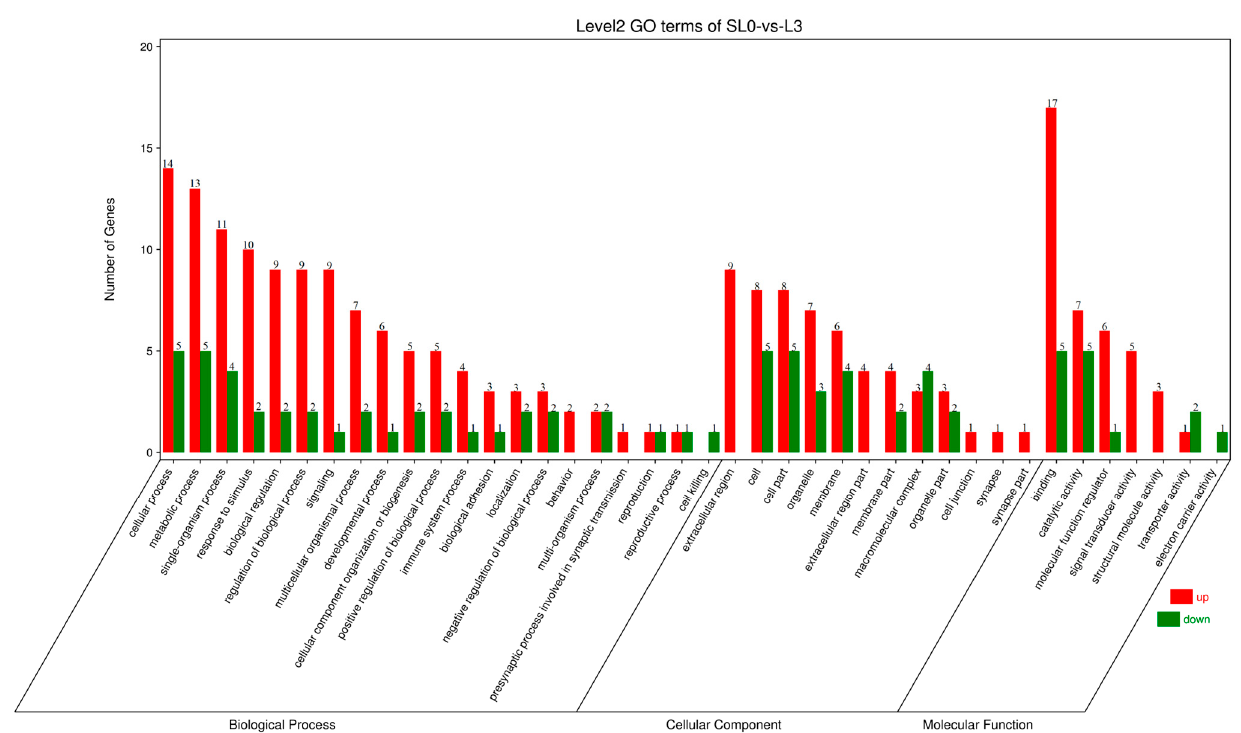
Figure 3. GO enrichment analysis of DEGs in the livers of juvenile hybrid groupers (SL0 vs L3). The abscissa is the enriched gene ontology (GO) term, and the ordinate is the number of differentially expressed genes in the term. The red columns represent up-regulated DEGs, and the green columns represent down-regulated DEGs.